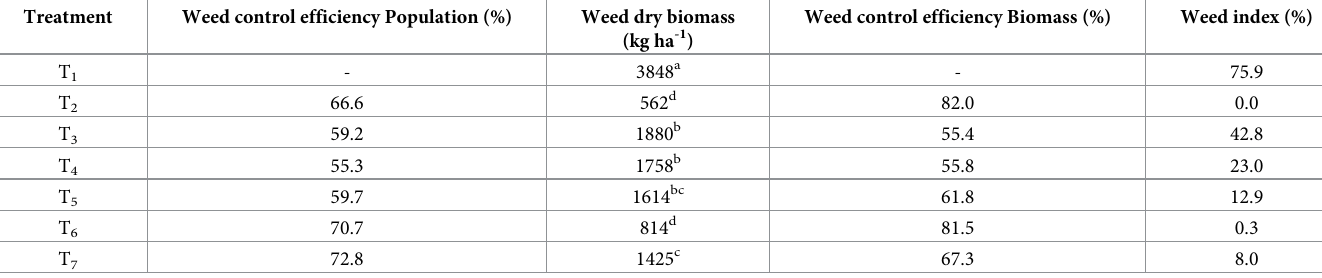
Table 4. Effect of different weed management practices on weed biomass, weed control efficiency (WCE) and weed index in soybean at harvest. Treatment Weed control efficiency Population (%)